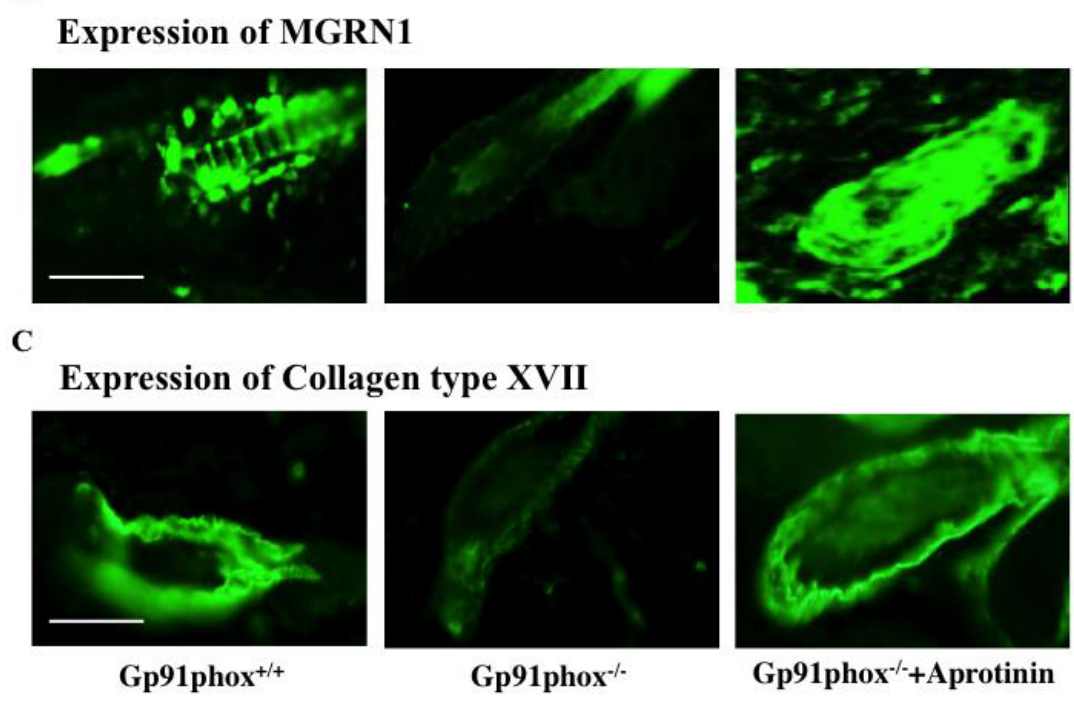
Figure 4. The effect of aprotinin on the hair color ( A ) and the effect of tranexamic acid on the expression of MGRN1 ( B ) and collagen XVII ( C ) in the twelve-months-old gp91phox −/− mice. The data show the results from one typical experiment involving six animals. Scale bar = 10 μm.